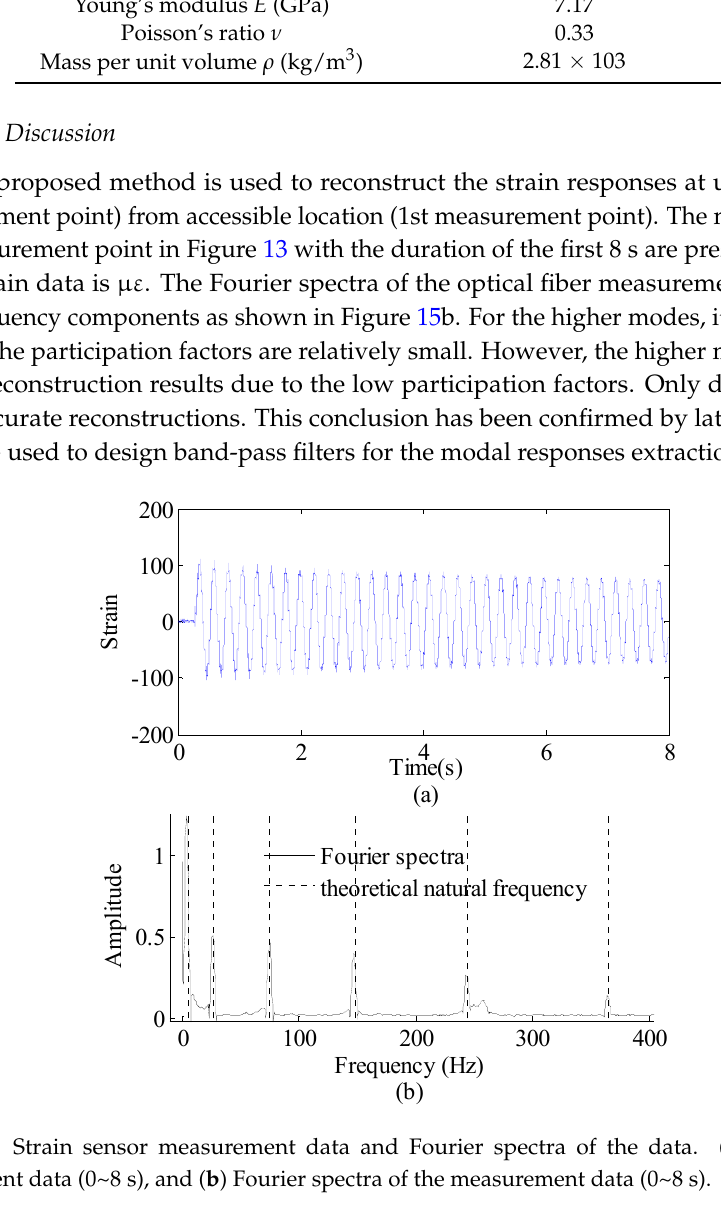
Figure 16. Modal responses of the 15-th optical fiber measurement data obtained by EMD method with intermittency criteria. To reconstruct strain response at the 15-th measurement point, the EMD method with intermittency criteria is employed to obtain modal responses. Table 4 gives frequency ranges for each band-pass filter. Figure 16 presents the modal responses obtained by the EMD method with intermittency criteria. The reconstructed strain response at the 15-th measurement point and the theoretical result are compared in Figure 17a. Figure 17b is the partial time-history chart of Figure 17a from 1.5 to 2 s. It is observed from Figure 17 that the reconstructed responses agree well with the theoretical solution except for the boundary region. The reconstruction errors in the beginning and end of signals are caused by the Gibbs phenomenon which has also been referred as